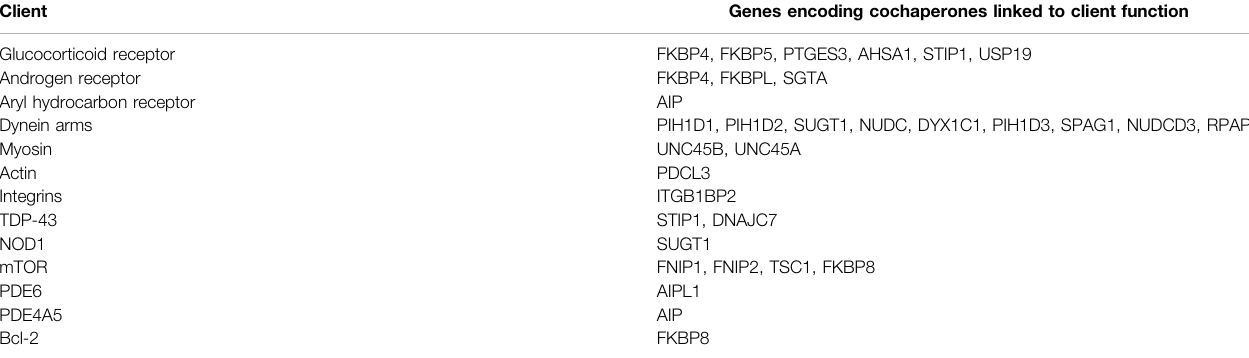
TABLE 2 | Cochaperone-client associations linked to human disorders.